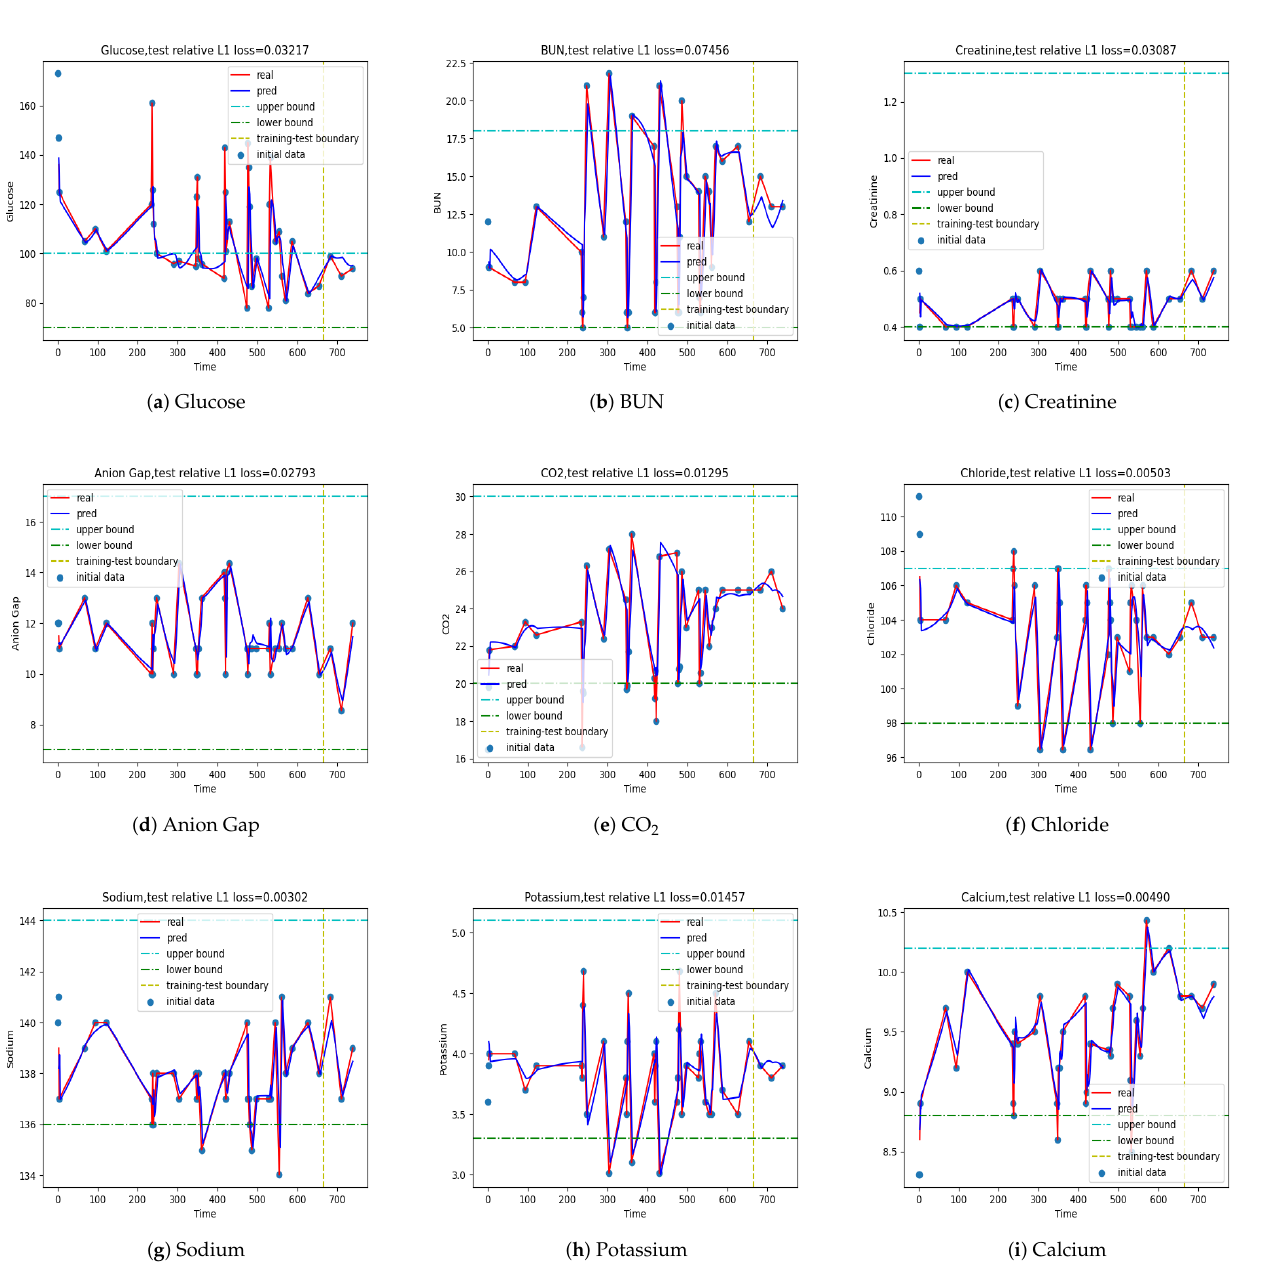
Figure 6. Output { ˆ x T + L + i − 1 , i = 1, · · · , } at T = 1, L = 3. The ones used in training are plotted on the left of the vertical line and the predicted ones on the